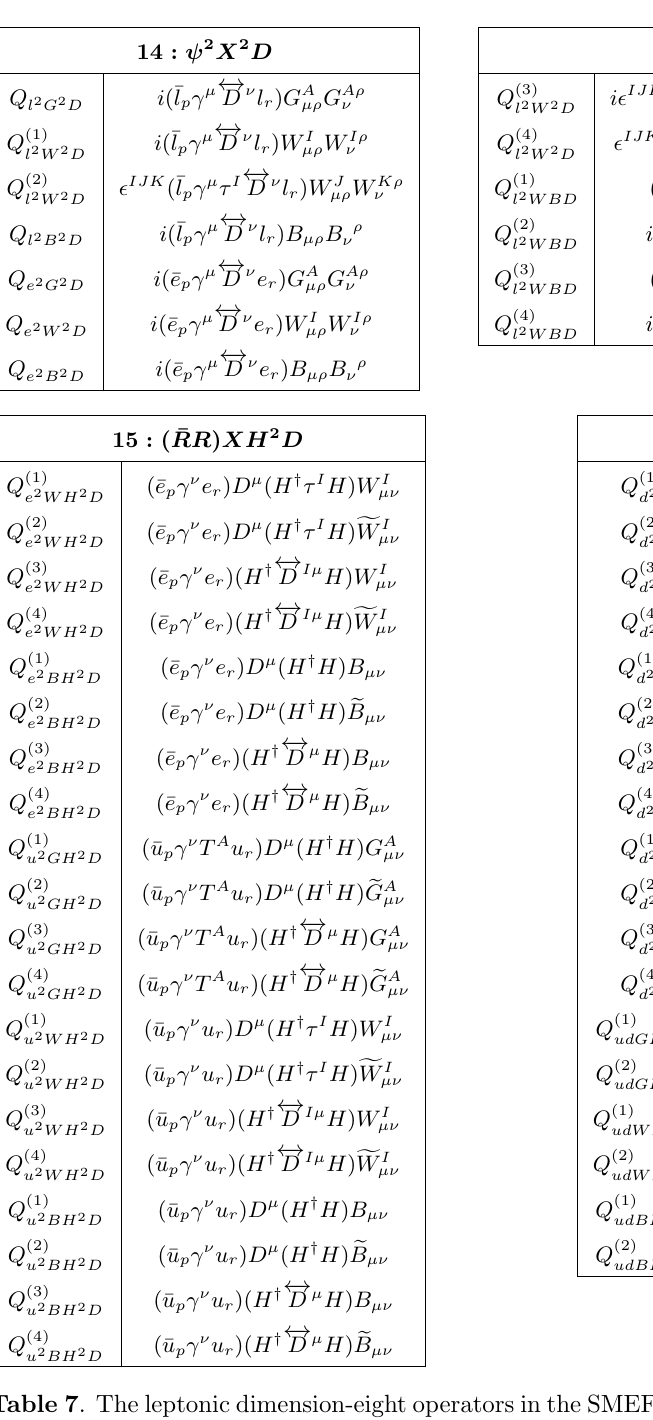
Table 7 . The leptonic dimension-eight operators in the SMEFT of class-14, and the dimension-eight operators of class-15 with (cid:12)eld content ( (cid:22) RR ) X 2 H . The operators Q conjugates. The subscripts p; r are weak-eigenstate